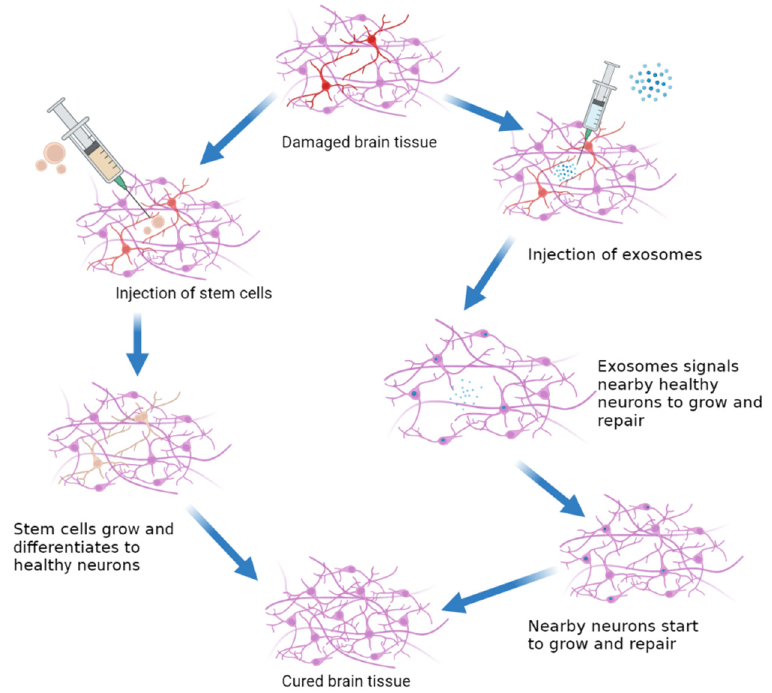
Figure 2. Simplified mechanism of action of stem cell therapy vs. exosomes.